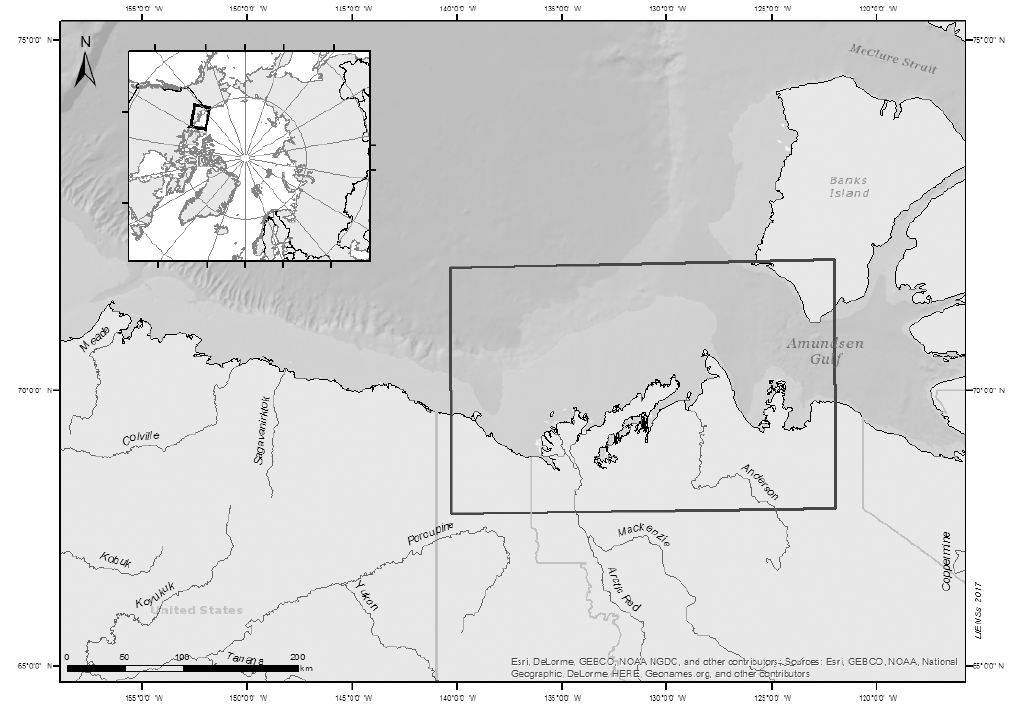
Figure 1. Map of the Canadian Beaufort Sea. The location of the study area is outlined with a